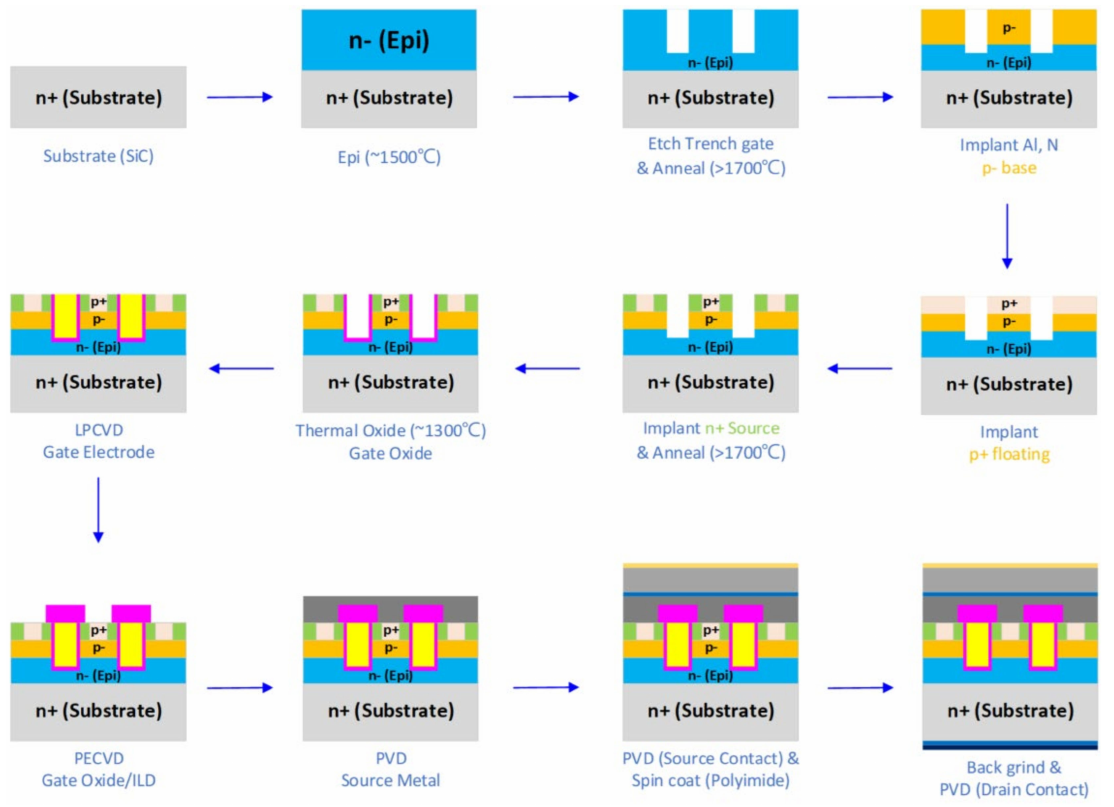
Figure 5. SiC MOSFET process